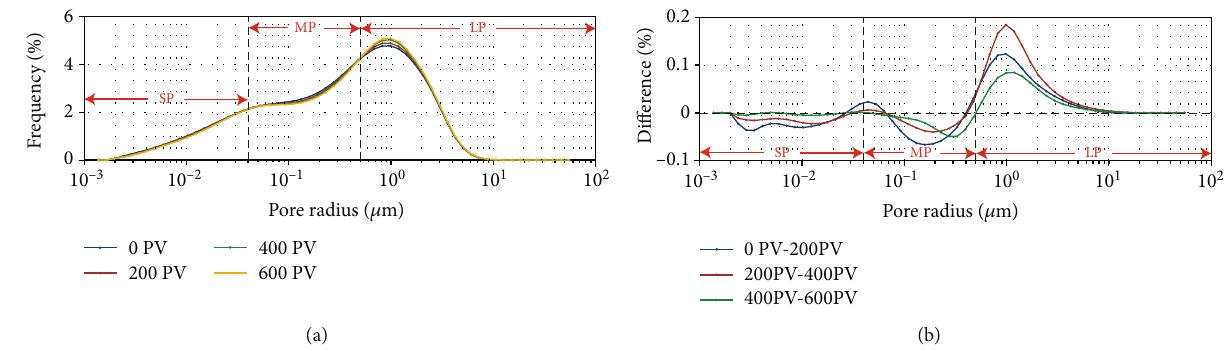
Figure 5: (a) Curves of pore-size distribution of C9-2 at four LTWF stages and (b) di ff erences between adjacent distribution curves.